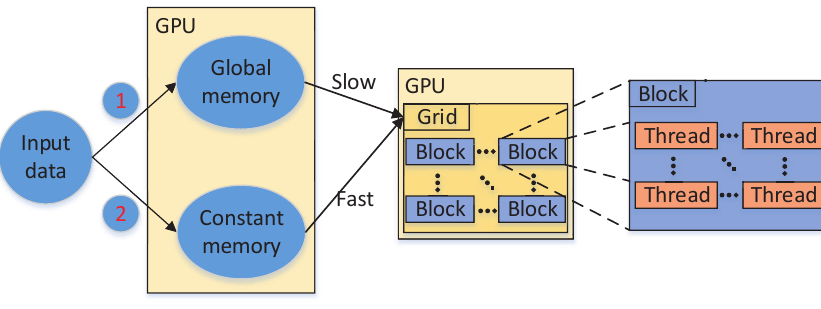
Figure 6. Storage optimization